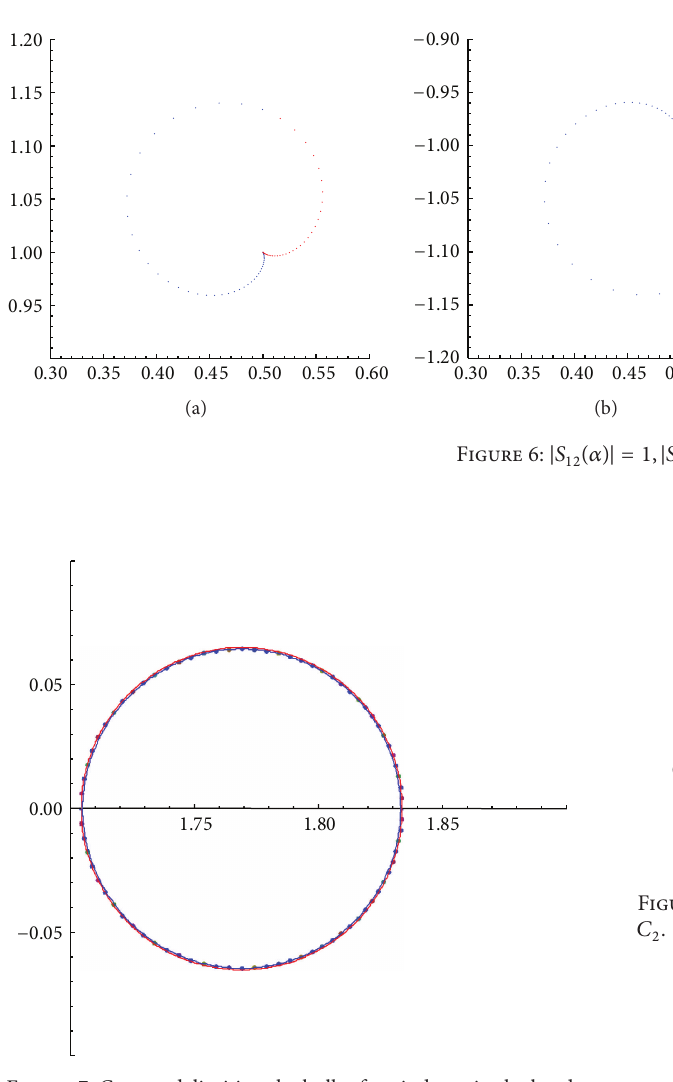
The stability function of these two circles |𝑆𝑡 14 (𝛼)| is drawn for 𝜕𝐶 1 : 𝛼 = 0.376 + 0.02𝑒 2𝜋𝑡𝑖 and 𝜕𝐶 2 : 𝛼 = 0.376 + 0.01𝑒 2𝜋𝑡𝑖 , 0 ≤ 𝑡 ≤ 1 , and can be seen in Figure 15 where the colour of stability function is the same as the corresponding circle. The dynamical planes for values of 𝛼 inside this bulb are similar to those obtained in Figure 2.